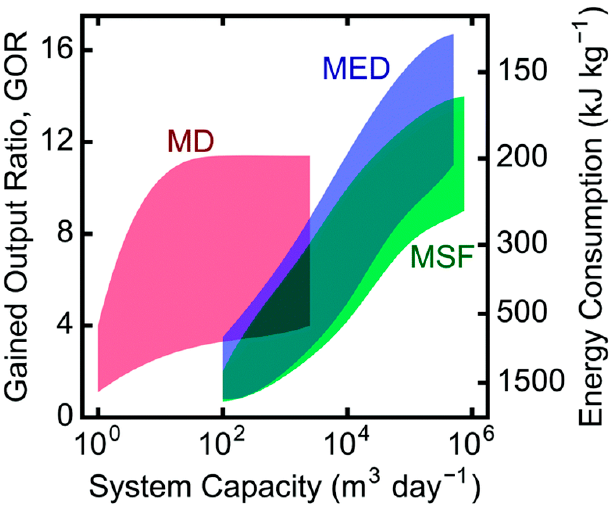
Figure 13. Distillation energy requirements (MD—membrane distillation, MED—multiple-effect distillation, MSF—multistage flash distillation) [[34]].